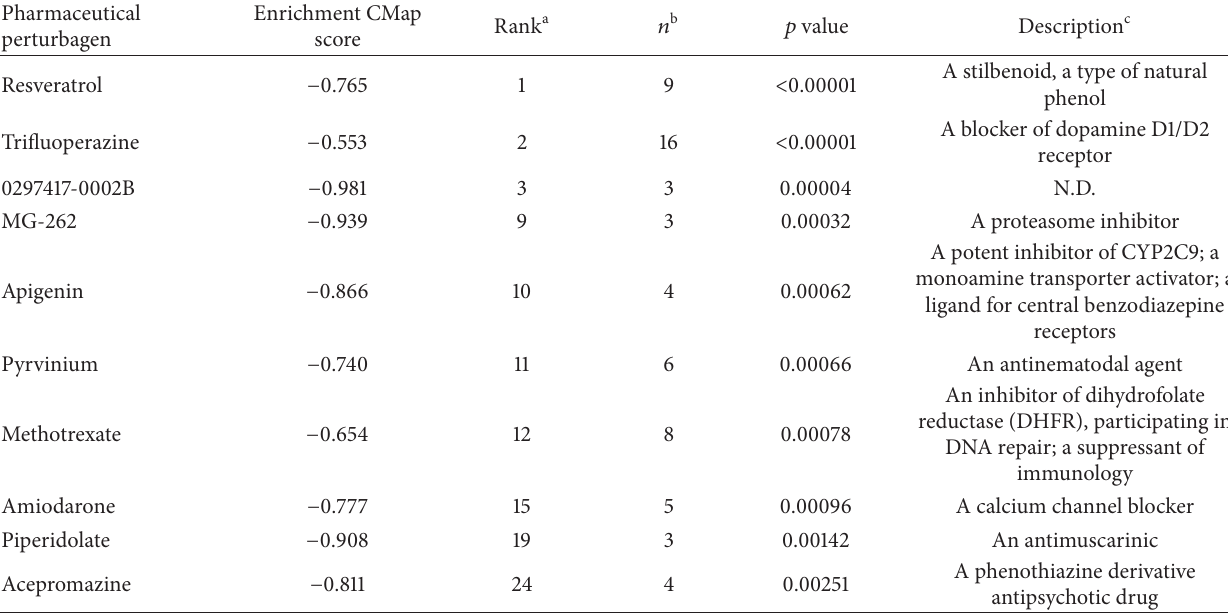
Table 6: Top 10 perturbagens identified through the Connectivity Map that anticorrelated with the CDH-associated signature.